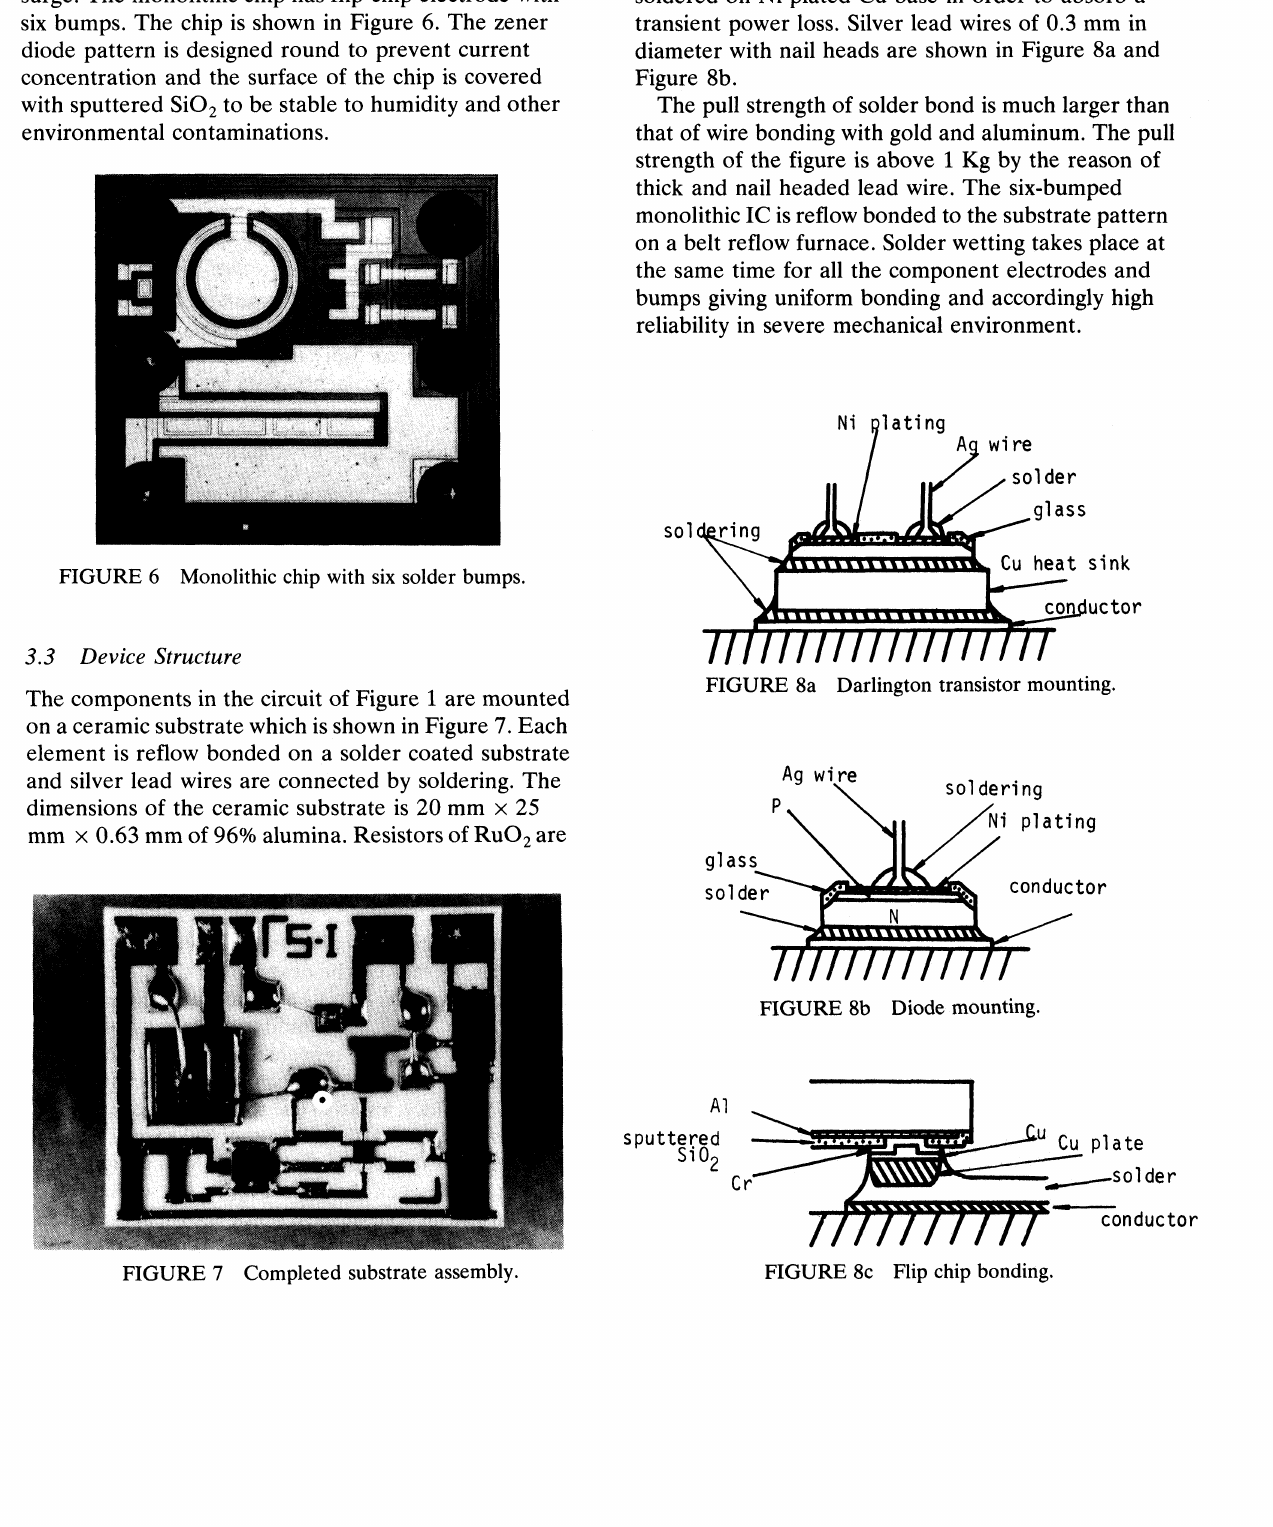
FIGURE 7 Completed substrate assembly. FIGURE 8c Flip chip